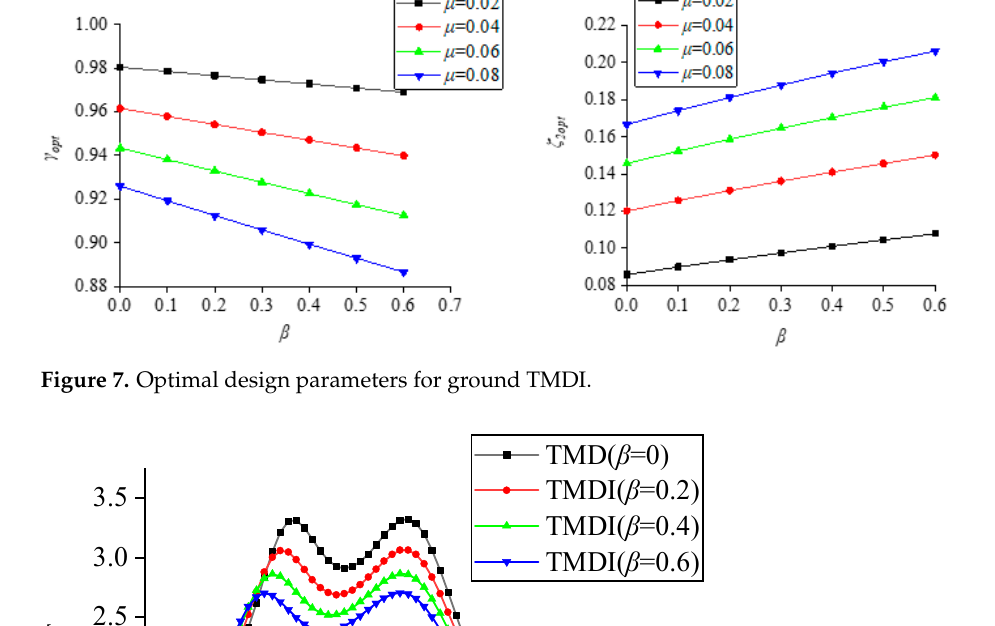
Figure 7. Optimal design parameters for ground TMDI.